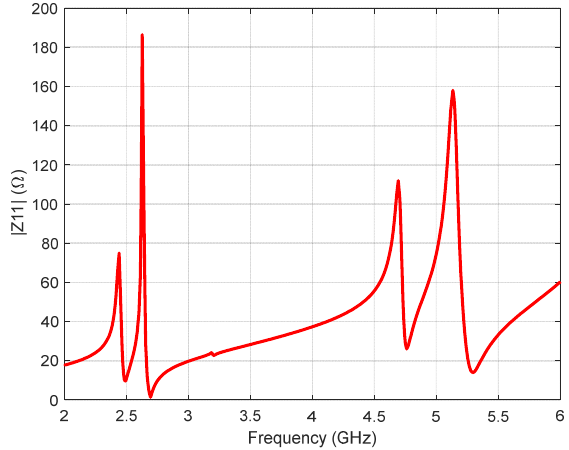
Figure 5. |Z11| plot of MPATSAT. The co-polarization (co-pol.) and cross-polarization (cross-pol.) are very important from the application point of view to analyze the performance of antennas. In Figure 6a–c, co-pol. and cross-pol. radiation diagrams of MPATSAT are shown in the y–z plane and x–z plane for 2.45 GHz, 4.73 GHz, and 5.21 GHz,